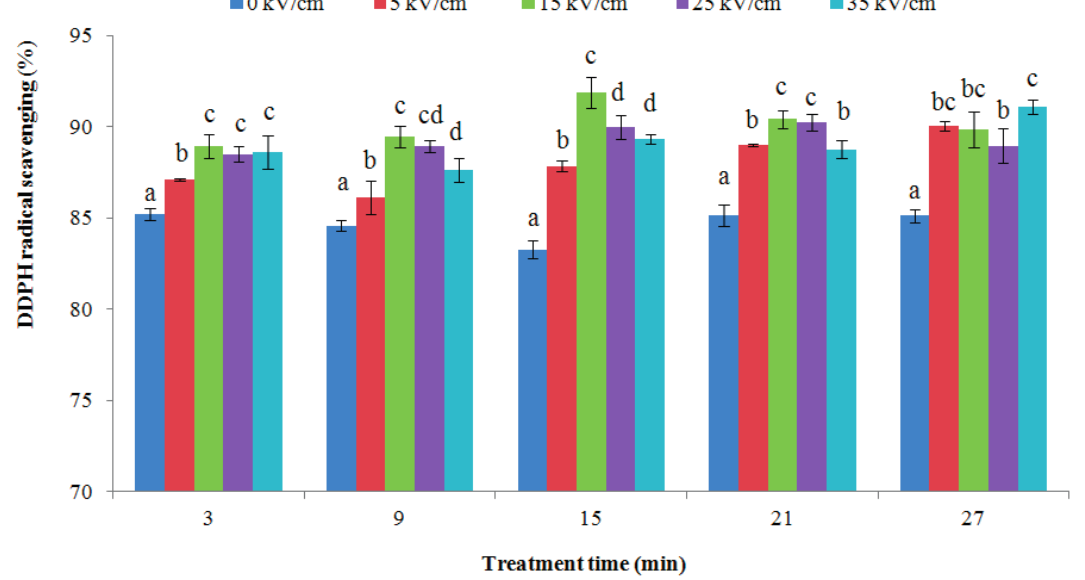
Figure 5. 1,1-diphenyl-2-picrylhydrazyl (DDPH) radical scavenging activity of VIT-C by PEF treatments. Values in columns followed by different letters mean significant